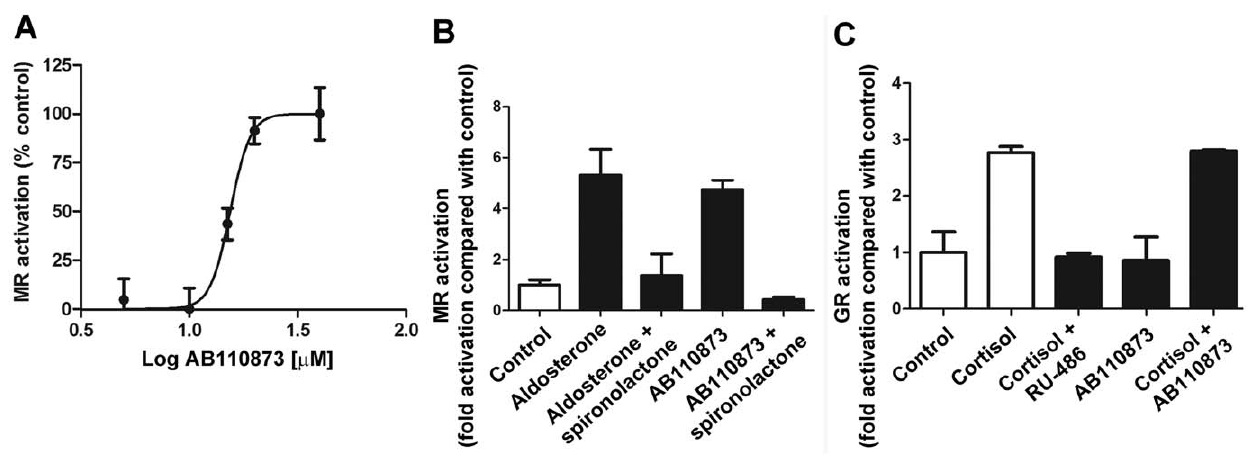
Figure 5. Effect of the silane AB110873 on the activation of mineralocorticoid (MR) and glucocorticoid receptors (GR). The impact of silane AB110873 on MR and GR transactivation was measured in HEK-293 cells transfected with MMTV-LacZ reporter, MR ( A,B ) or GR ( C ) and luciferase transfection control. Cells were incubated with the receptor ligands for 24 h, followed by analysis of reporter activity as given in the Methods section. A , Concentration-dependent activation of the human MR by the silane AB110873. Maximal activation at 30 m M was set as 100%. B , effect of the antagonist spironolactone (1 m M) on MR activation by aldosterone (5 nM) or by the silane AB110873 (20 m M); C , activation of human GR by cortisol (100 nM) and effect of AB110873 (20 m M) and antagonist RU-486 (1 m M) (MR and GR activity of the vehicle control was set as 1, data represent fold activation). Data were obtained from four independent experiments, each performed in triplicates (mean 6 SD). a concentration-dependent manner. At 30 m M AB110873 IL-6